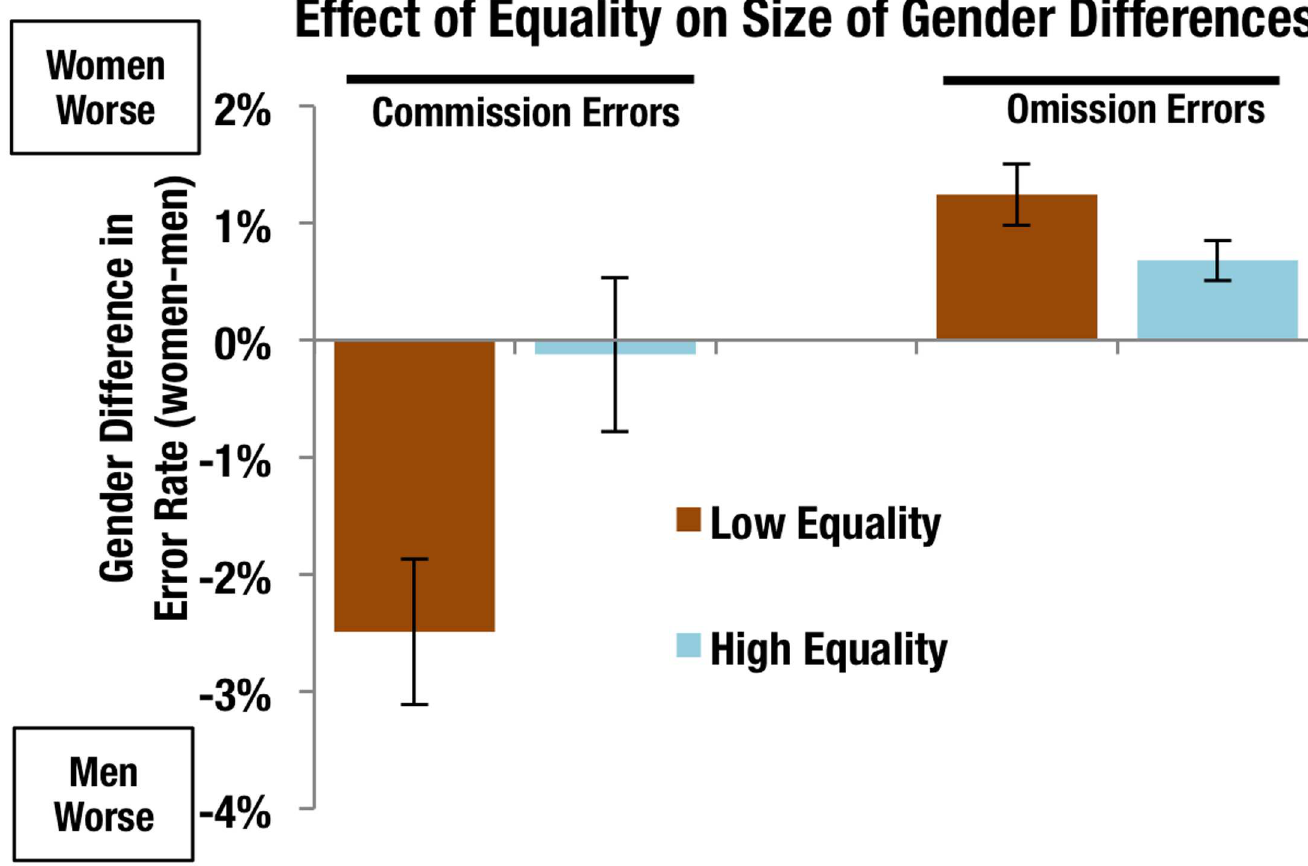
Fig 2. Gender differences in age corrected error rates in low and high gender equality conditions. Error bars show standard error. Low and high equality were defined as the countries in the bottom and top quintile of our sample accordingto the United Nations’s Gender InequalityIndex. N = 8 countries per quintile, low equality N = 2,066 (Egypt, India, Pakistan, Bangladesh,Indonesia, South Africa, Brazil, Phillippines) high equality N = 1,657 (Germany, Sweden, Denmark, Netherlands, Italy, Norway, Belgium, Finland). doi:10.1371/journal.pone.0165100.g002 Table 5. Pearson correlation coefficients and corresponding p-values for relationships between sociocultural indices and gradCPT gender dif- ferences (women—men). Variable Index Pearson’s R P Value CE gender diff. SIGI